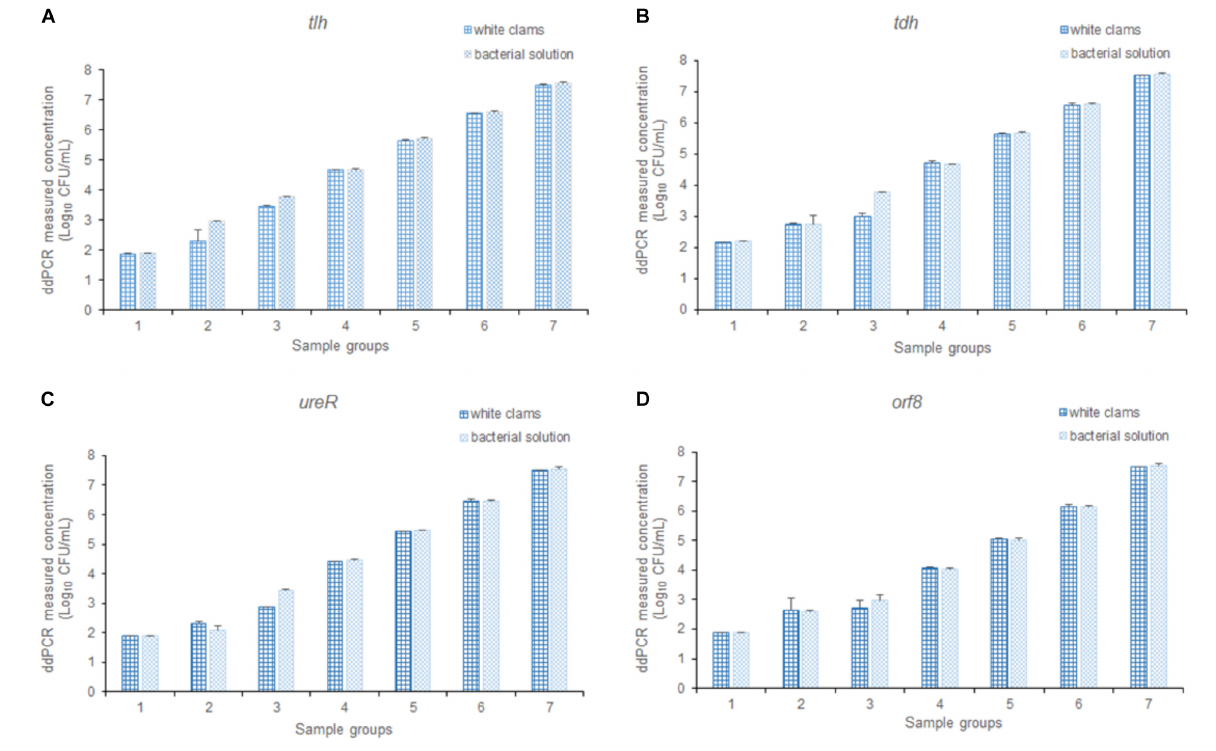
FIGURE 7 | The detection results of V. parahaemolyticus in solution and spiked white clams, analyzing (A) tlh , (B) tdh , (C) ureR , and (D) orf8 , respectively. Plotted values represented the mean value and standard deviations obtained from three triplicate